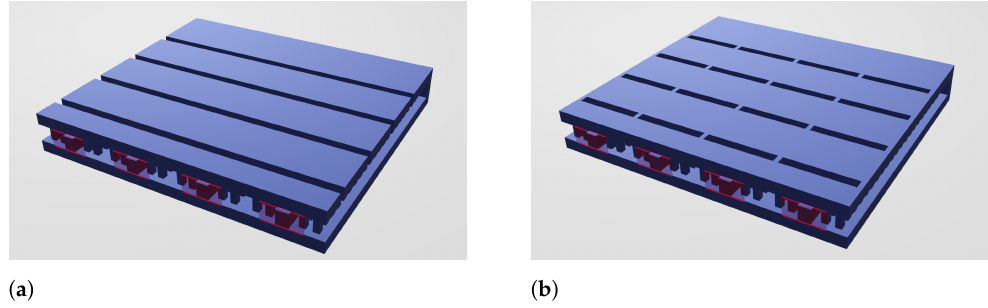
Figure 4. CTS excitation by means of a combination of RGW: conventional CTSs ( a ) and short TSs ( b